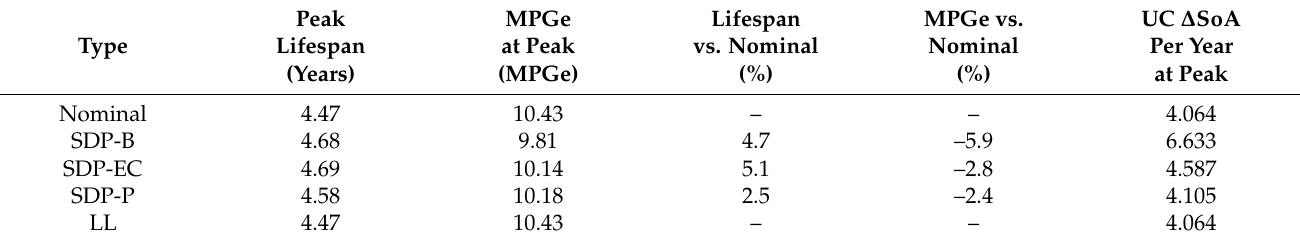
Figure 10. Comparison of energy consumption and UC aging for the four causal control methods, N pc = 40. Table 5. Comparison of Causal Controllers, small HESS ( N pc = 10).